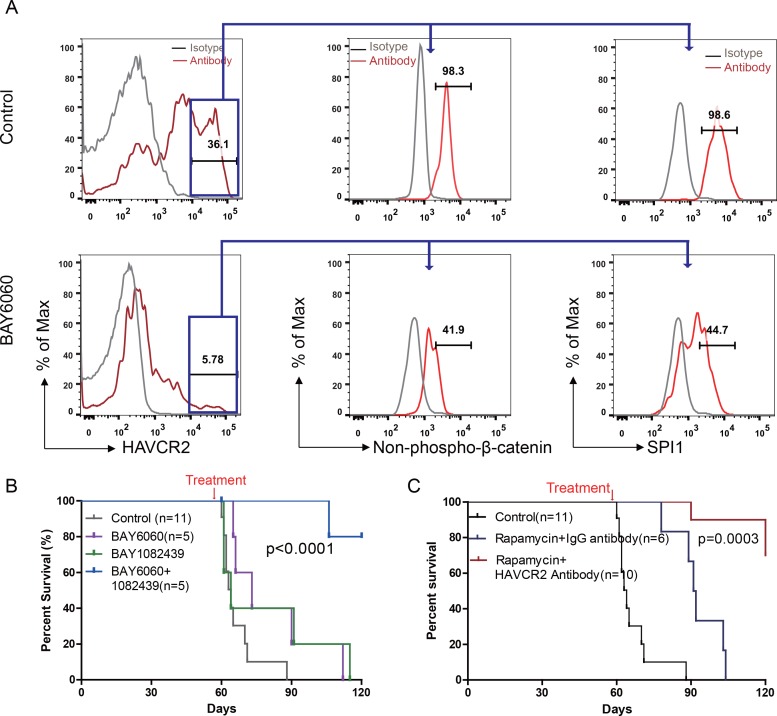
Cotargeting oncogenic driver mutations and LSC ‘stemness’ maintenance circuit.(A) Comparison of the HAVCR2high subgroup population (left panel) and of the levels of non-phosphorylated β-catenin (middle panel) and SPI1 (right panel) within the HAVCR2high subgroup without (upper panels) and with BAY6060 treatment (low panels); (B) Survival curve for Cdh5-Cre+;PtenL/L mice treated with BAY6060 and BAY1082439 alone and in combination; (C) Survival curve for Cdh5-Cre+;PtenL/L mice treated with rapamycin in combination with either an IgG control antibody or an anti-HAVCR2 antibody.